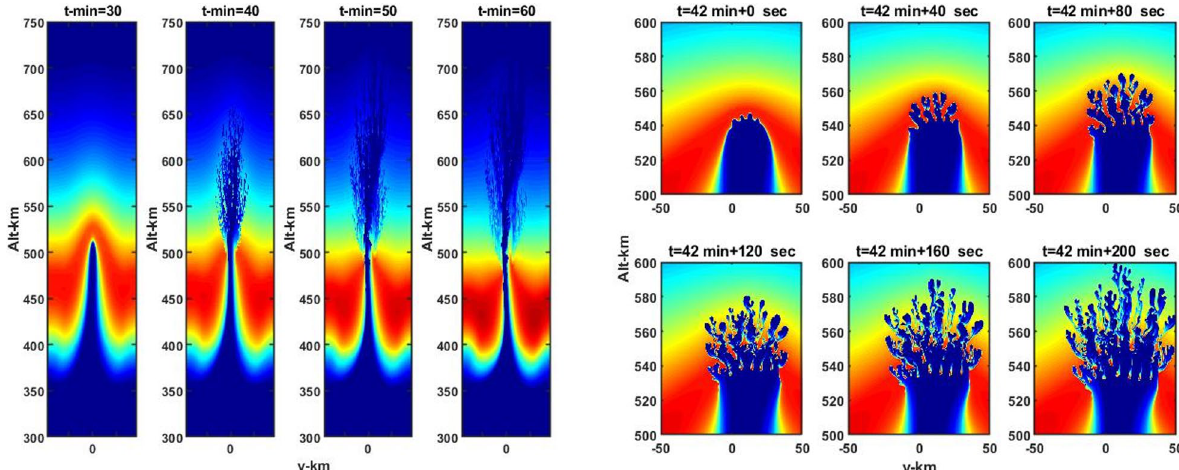
Fig. 1 The left frame summarizes the single-bubble development at 10-min intervals starting at the bubble penetration of the F-region peak. The color display scale is linear 0 to 10 11 / m 3 . The right frame shows a zoomed 10-s sequence of the structure onset